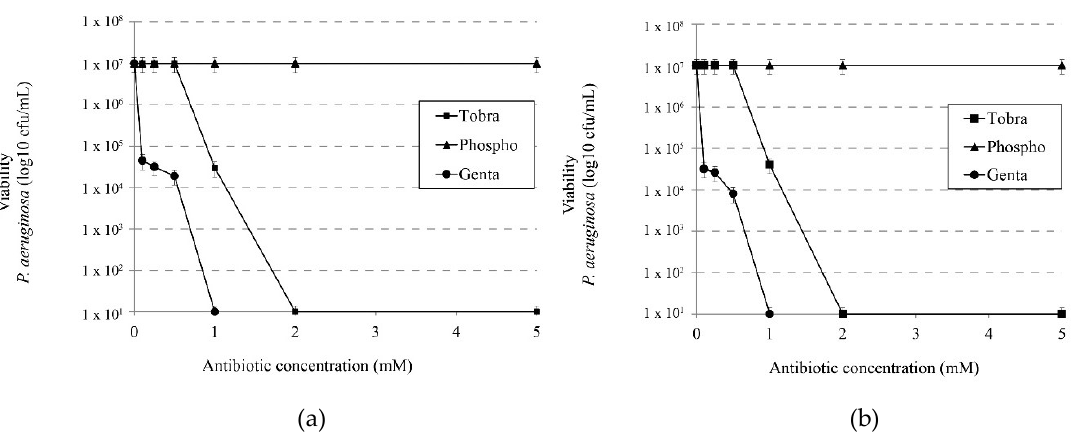
Figure 5. Effect of ionic strength on the microbicidal activity of different antibiotics. Effects of tobramycin, phosphomicine and gentamicin on viability of P. aeruginosa without ( a ) 1 M NaCl and ( b ) with 1 M